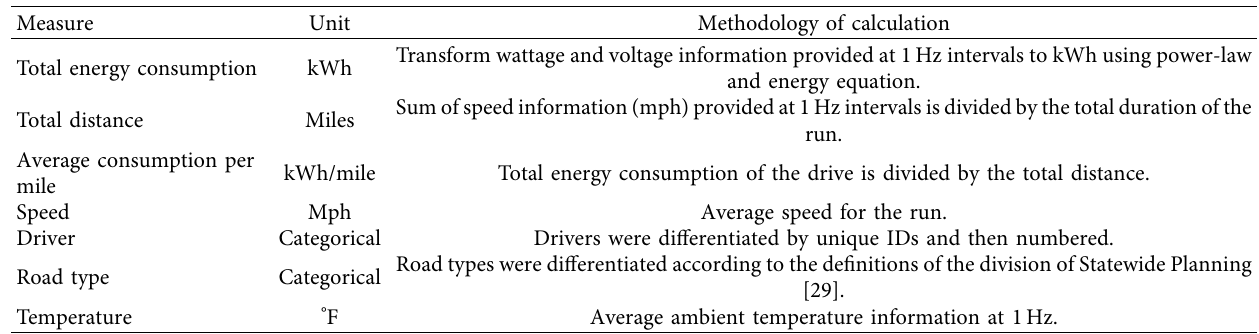
Table 4: Variables and explanation of